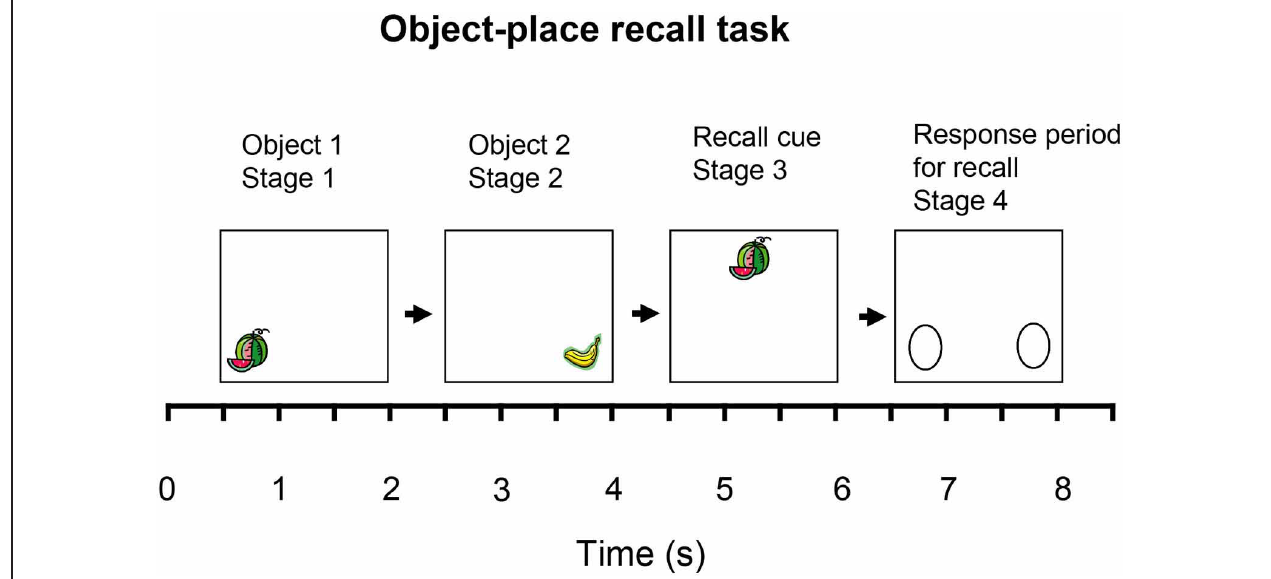
object shown as the recall cue in stage 3 was presented, and must then touch that place on the screen to obtain 4 licks of fruit juice, thus indicating that he has recalled the location correctly. In stage 4 of the trials, the left and right positions (P1 and P2) have no image present, with the two possible locations for a response indicated by identical circles. The task requires the monkey to perform recall of the place from the object, within the period beginning at the presentation of the recall cue at the start of stage 3 and ending when the response is made in stage 4. Reward associations can not be used to solve the task, for the two objects and the two places are not differently associated with reward. Further details are provided by Rolls and Xiang